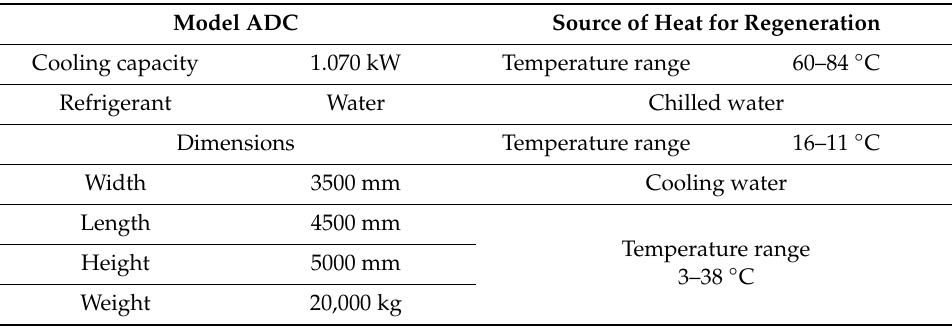
Table 3. Technical specification of the New Energy Transfer chiller [29].